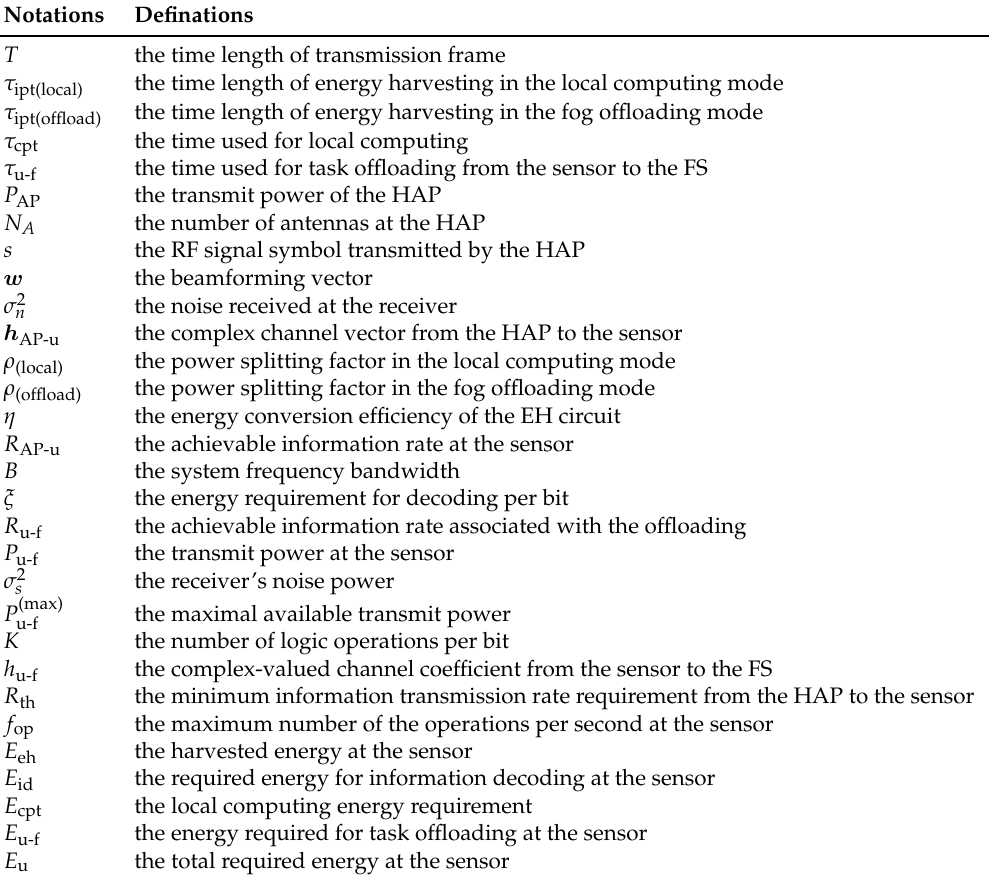
Table 1. The notation